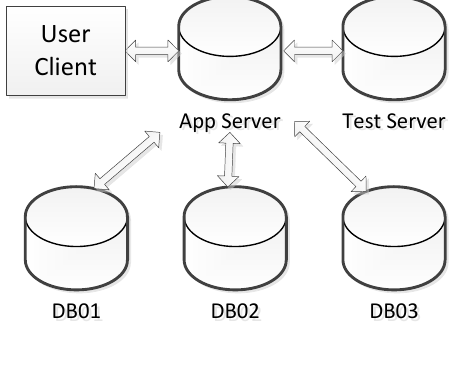
Figure 2. Mongodb